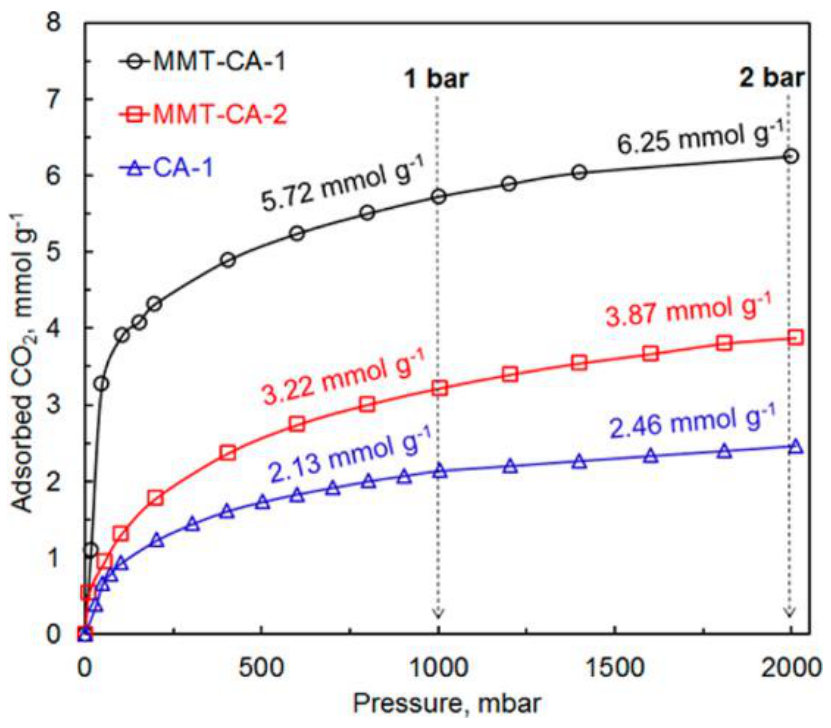
Figure 41. CO 2 adsorption of MMT-CA-1 (highest micropore volume), MMT-CA-2 (highest BET surface area), and CA-1 benzoxazine samples with varying clay concentrations (reproduced from the work in [37] with permission).